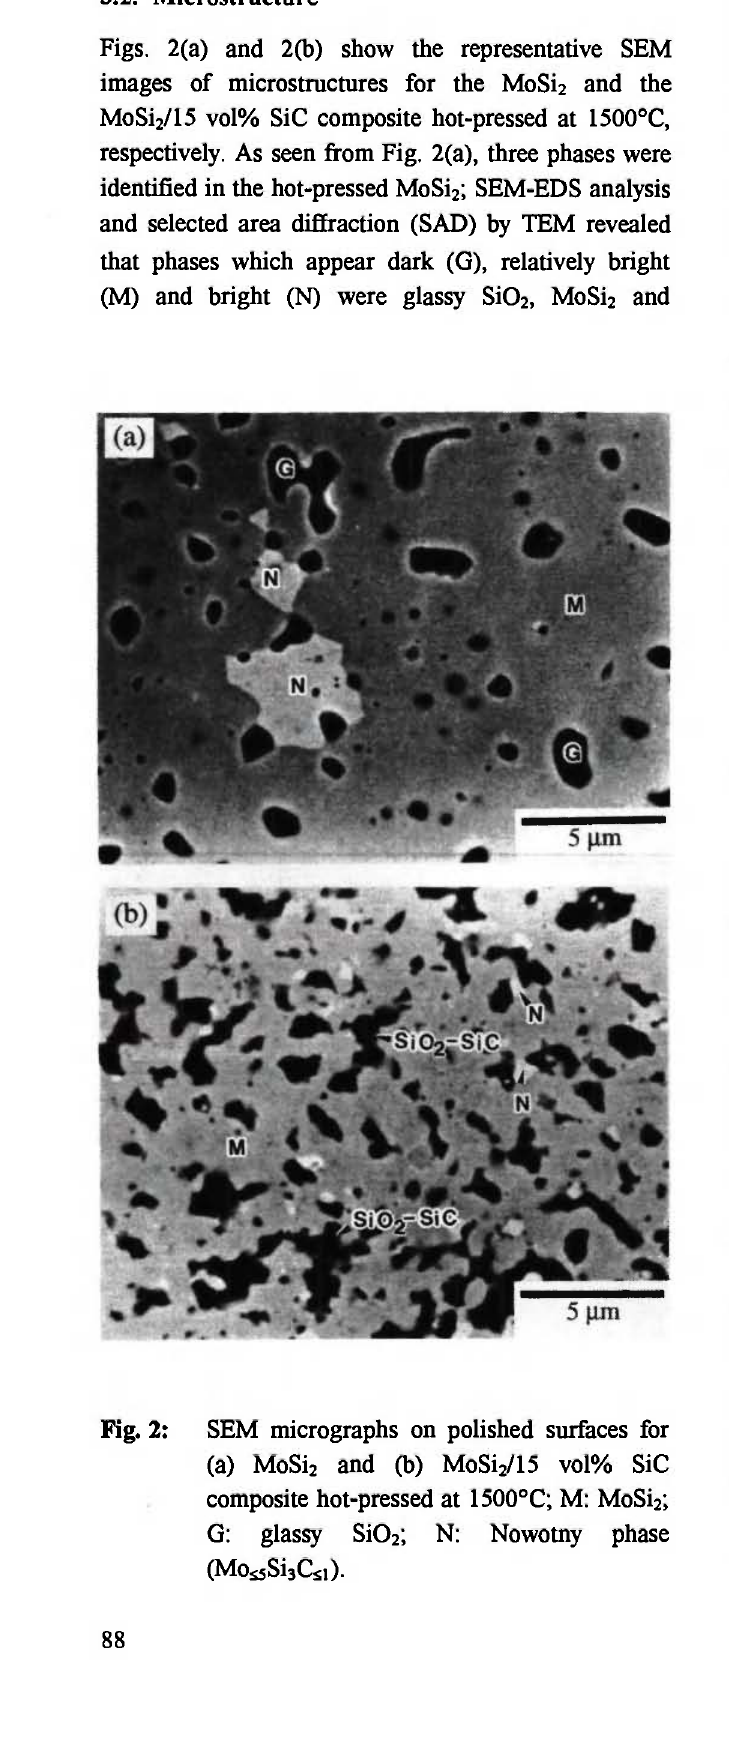
Fig. 2: SEM micrographs on polished surfaces for (a) MoSi and (b) MoSi /15 vol% 2 2